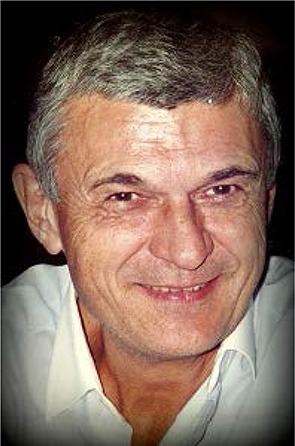
This paper is dedicated to the memory of Dr. Yves Durandy (1947–2016).